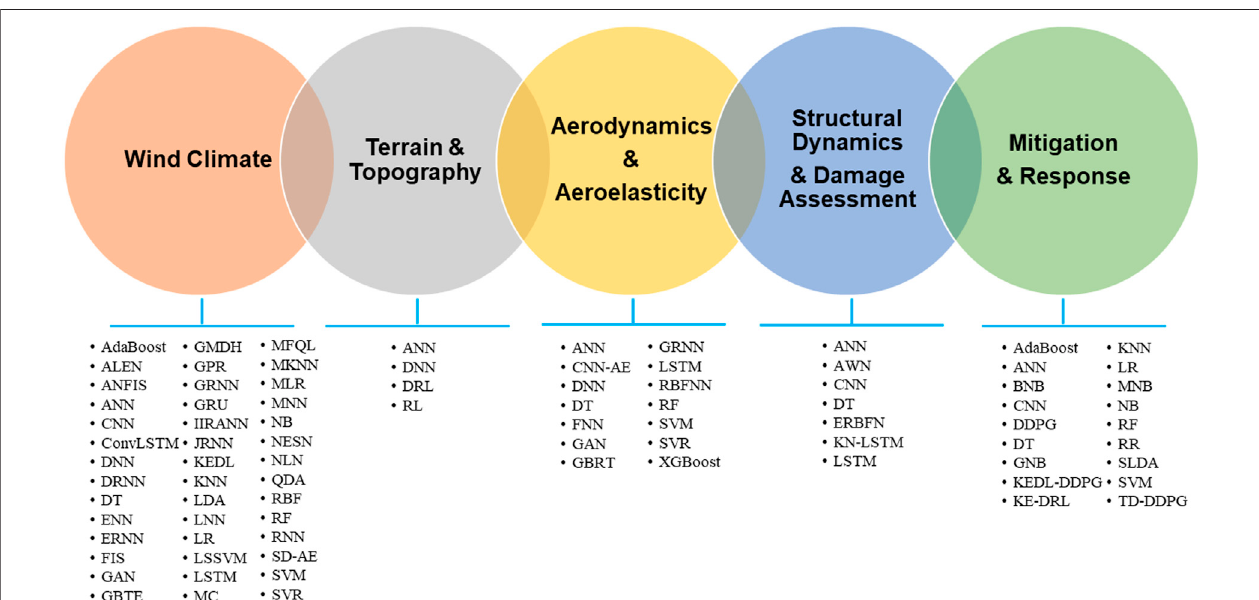
FIGURE 8 | Overview of reviewed ML applications in wind engineering (following Alan G. Davenport Wind Loading Chain).